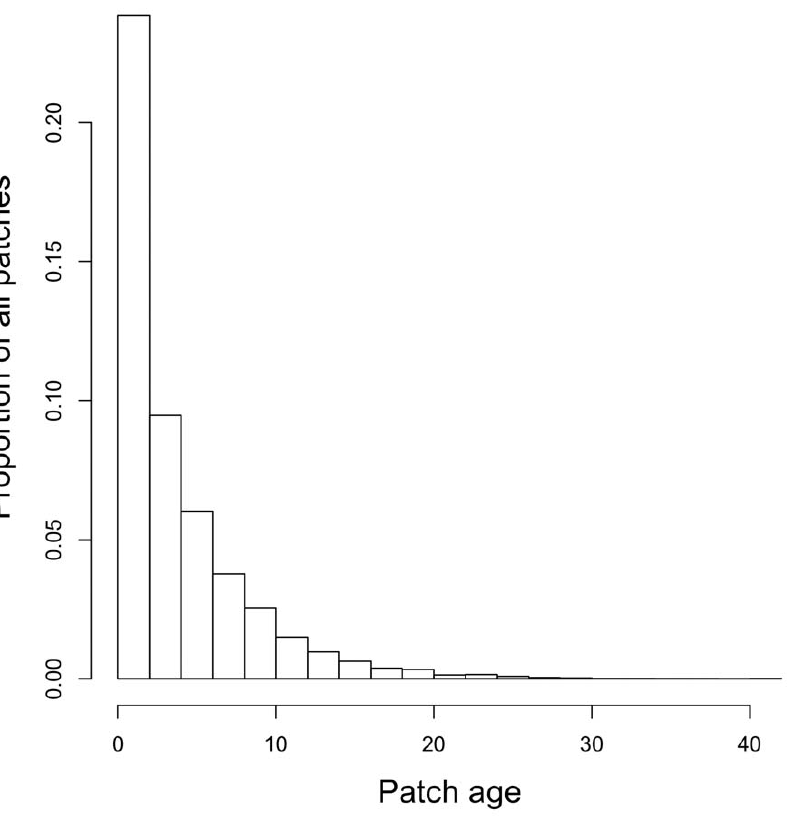
Figure 5. Frequency histogram of age categories (time since last fire measured in years) at a fire frequency of 0.2.